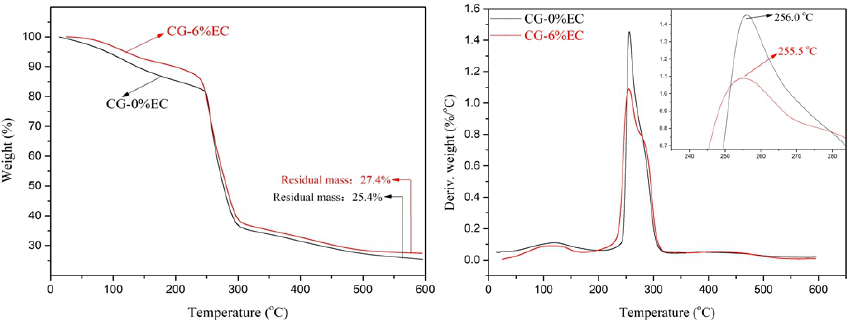
Figure 8. TG and DTG Analysis of raw materials and films.